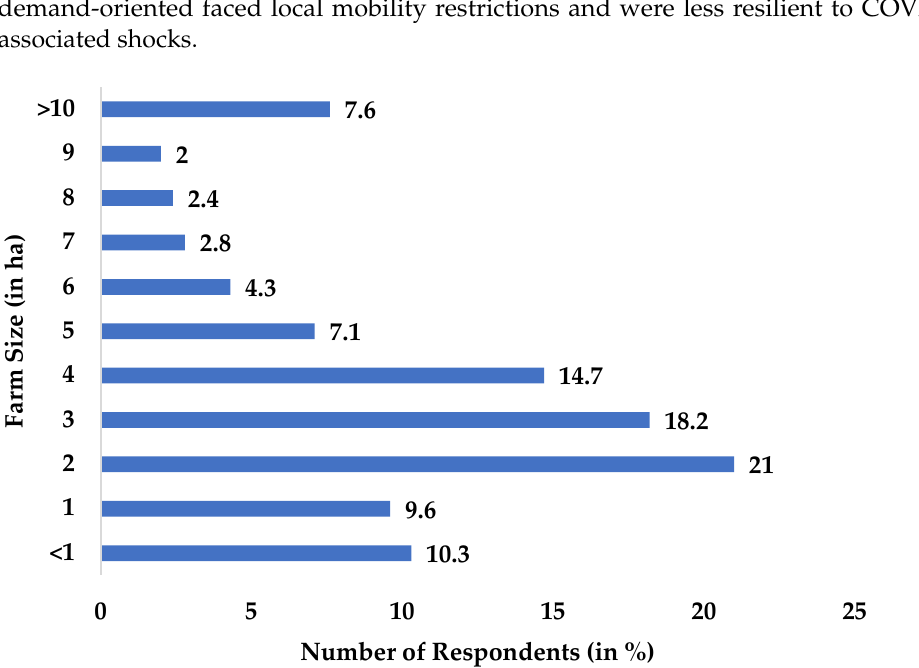
Figure 2. Farm size of survey respondents ( n = 866).